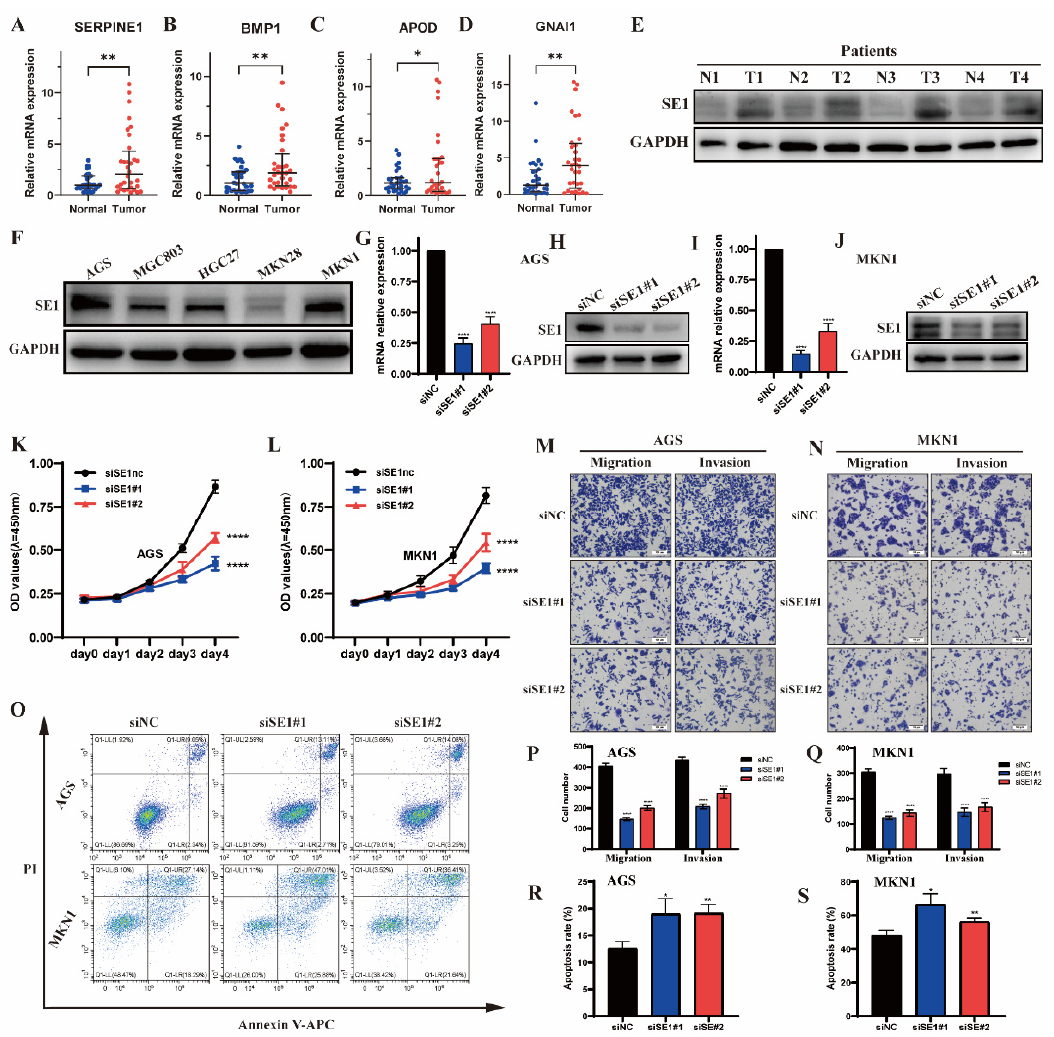
Figure 7. SERPINE1 promotes the malignant biological behaviors of GC cells. SERPINE1 ( A ), APOD ( B ), GANI1 ( C ) and BMP1 ( D ) mRNA and SERPINE1 ( E ) protein levels were measured in GC tissues, and adjacent normal tissues were paired by qPCR and Western blotting, respectively. Western blotting analyses of SERPINE1 protein levels in GC cell lines ( F ). Western blot and qPCR analyses of SERPINE1 levels in GC cell lines transfected with the si SERPINE1 ( G – J ). CCK8 assay of cell growth with SERPINE1 silencing and control group ( K , L ). Representative images and quantification of migration and invasion in SERPINE1 silencing and control GC cell lines ( M , N , P , Q ). Apoptosis assay and the quantitative analysis of SERPINE1 in silencing and control group ( O , R , S ). Data were presented as the mean ± SD. Wilcoxon test, * p < 0.05; ** p < 0.01; **** p < 0.0001.